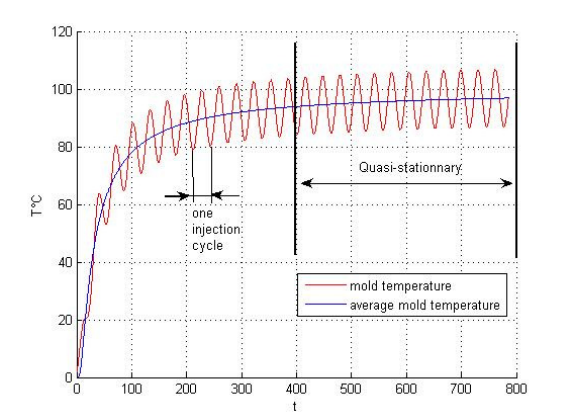
Fig. 2. Temperature at the surface of the mold versus time (in seconds).